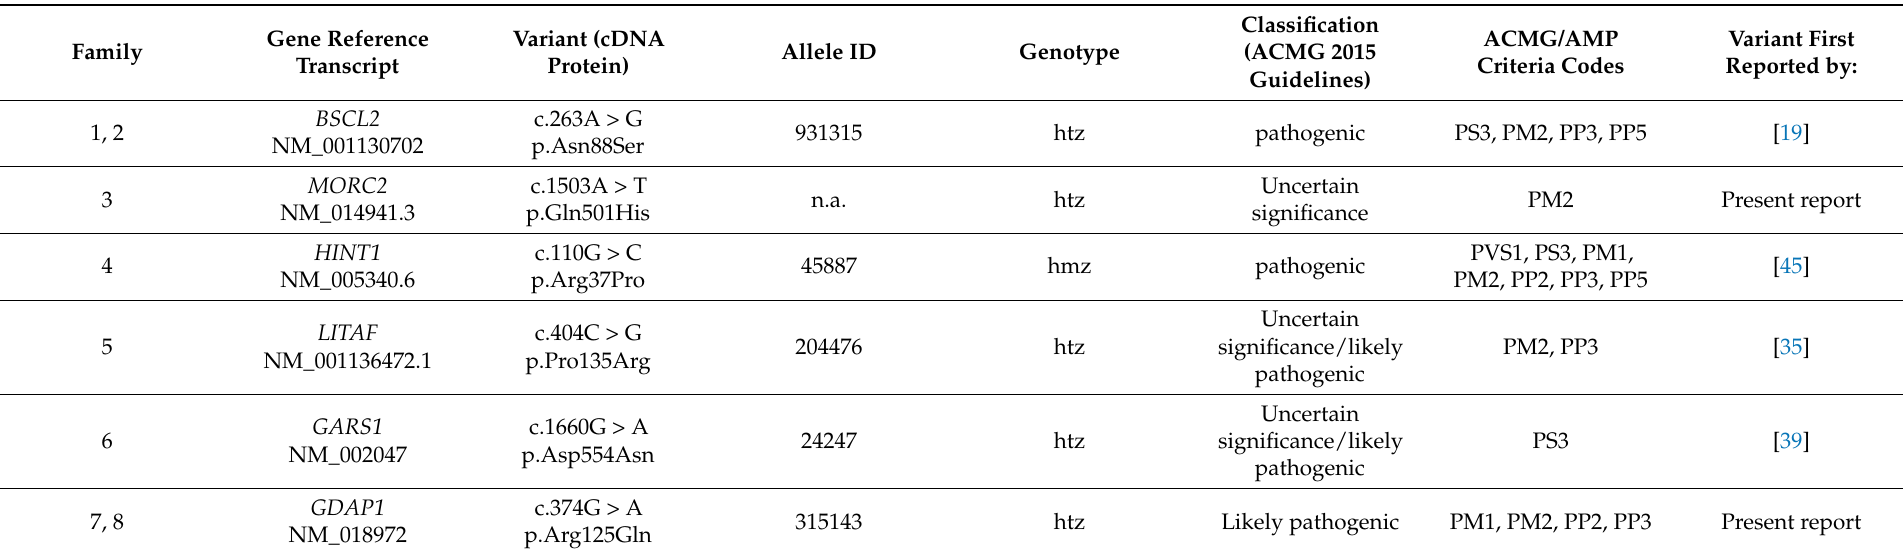
Table 2. Genetic analysis results of the eight families